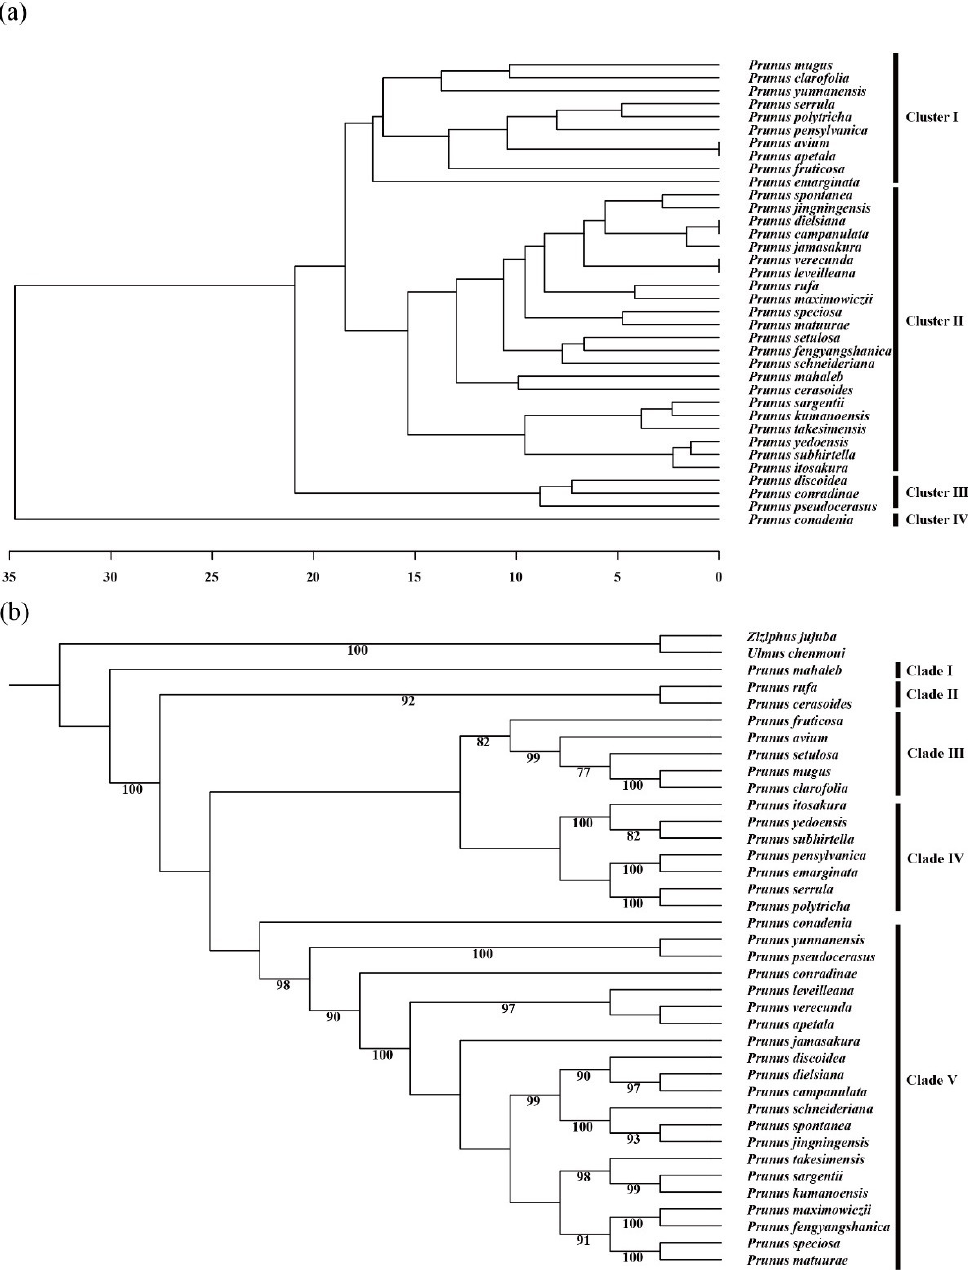
Figure 7. ( a ) Cluster of 36 subg. Cerasus chloroplast genomes based on RSCU values; ( b ) CDS-based reconstruction of a phylogenetic tree of subg. Cerasus .